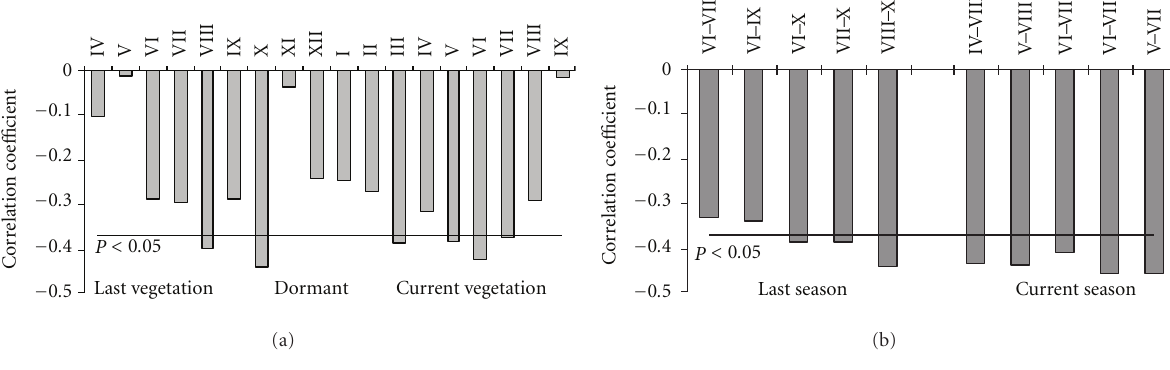
Figure 8: Relationships between the residual of beech tree ring width indices and monthly and seasonal mean concentrations of surface ozone over 30-year